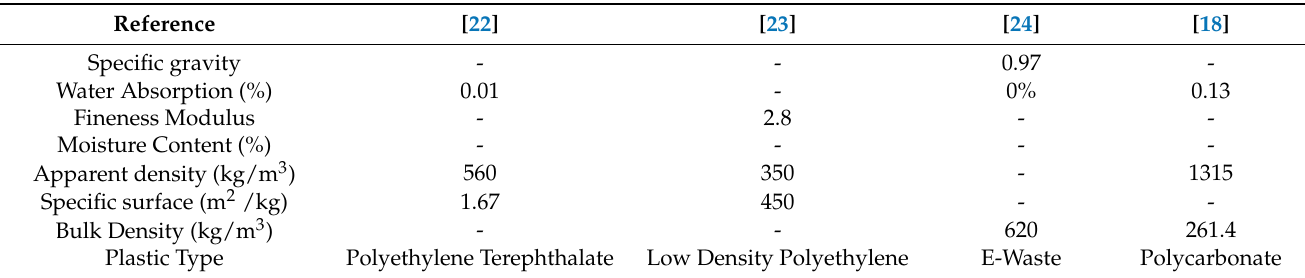
Table 1. Properties of Plastic Waste (PW) Used in concrete.